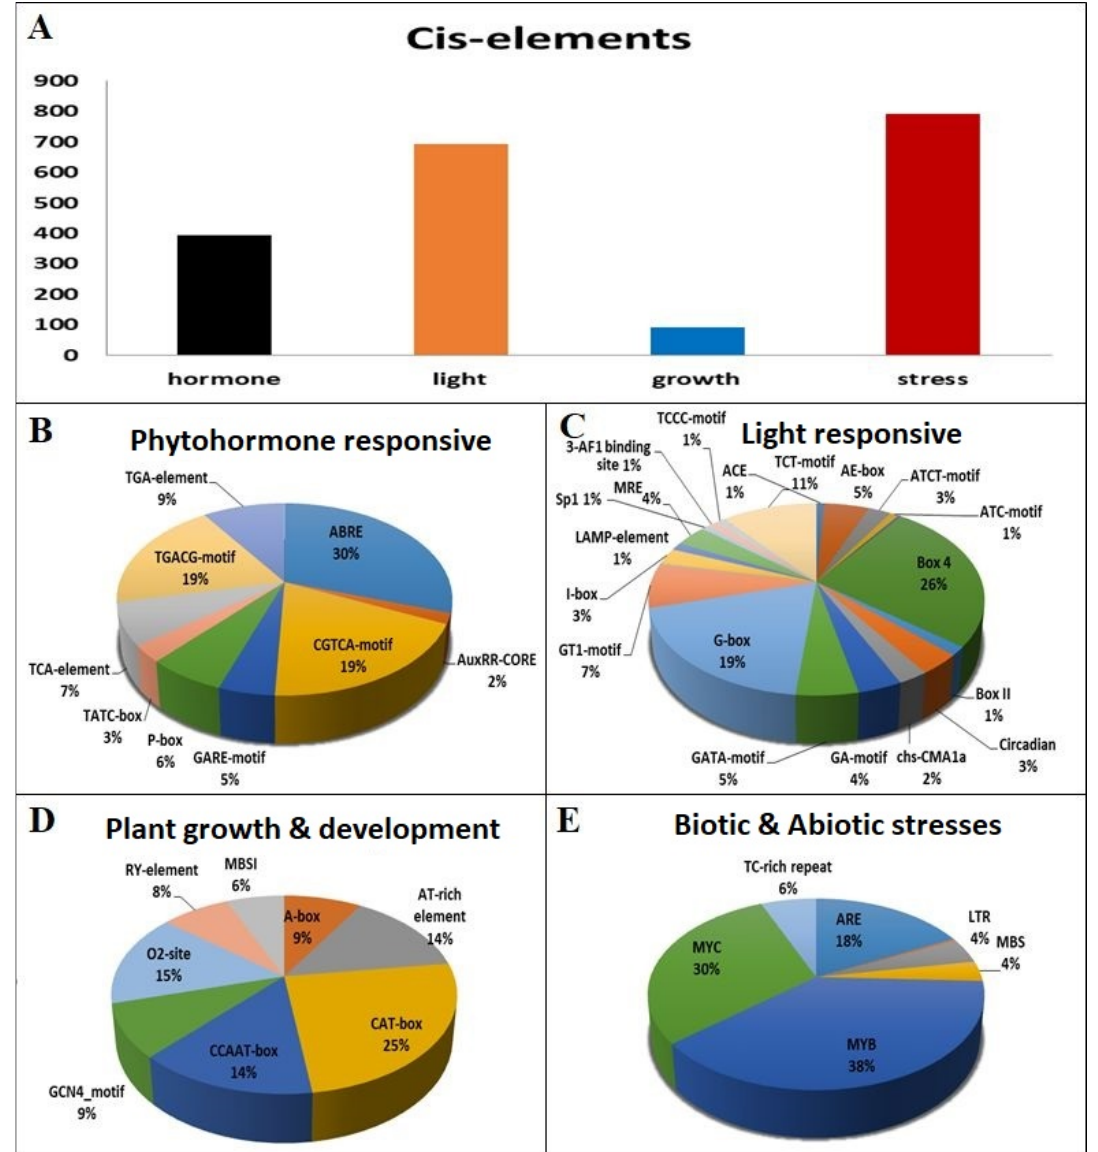
Figure 8. The regulatory elements analysis of the Arabidopsis GLK gene promoters. The total number of cis-acting elements in a different category was shown with a different colored histogram ( A ). The identified cis-acting element in each category of Arabidopsis was represented by pie charts ( B – E ).